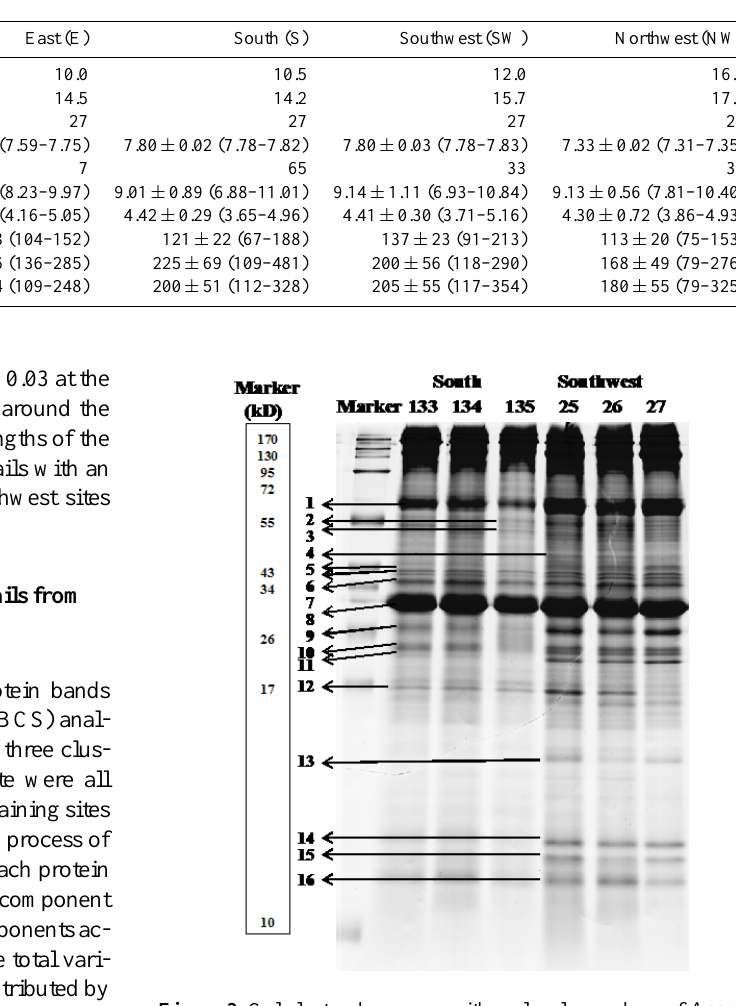
Table 2. Environmental parameters and shell traits of Anachis misera around the vent off Kueishan Islet. Data are shown as mean ± SD (range of paramenter). SL: shell length; SW: shell width; TW: total weight; T1: thickness of body whorl; T2: thickness of penultimate whorl. Means that differ significantly from each other are indicated by different letters.